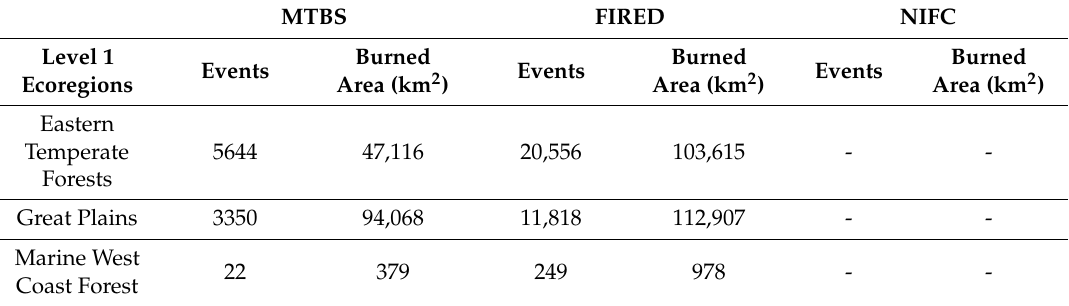
Figure 1. A comparison of the spatial distribution of fire events from the ( A ) MTBS and ( B ) FIRED products from 2001–2017 aggregated to 50 km 2 pixels shows a similar distribution of fire events and burned area in general, but the FIRED algorithm picks up many more events and burned area in the midwest, southeastern US, and eastern Washington. Table 6. Fire events and burned area by level one ecoregion, 2001-2016. National Interagency